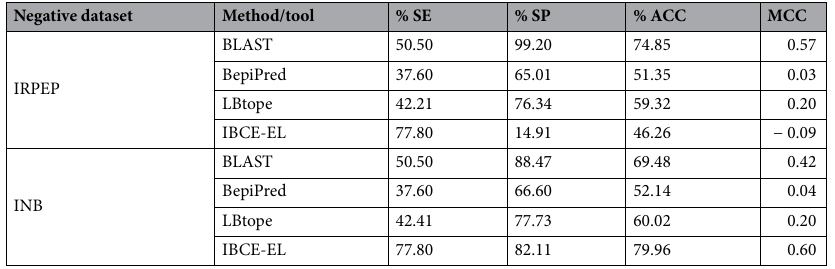
Table 2. Comparative performance of B cell epitope prediction methods. Table reports the sensitivity (% SE), specificity (% SP), accuracy (% ACC) and Matthew’s correlation coefficient (MMC) of the BLAST-based method, BepiPred, LBtope and IBCE-EL discriminating B cell epitopes in the BECIP dataset from non-B cell epitopes in two different datasets (IRPEP and INB). B cell epitope predictions with LBtope and IBCE-EL were carried out at the relevant web sites and BepiPred predictions were carried out using the standalone version of BepiPred (details in